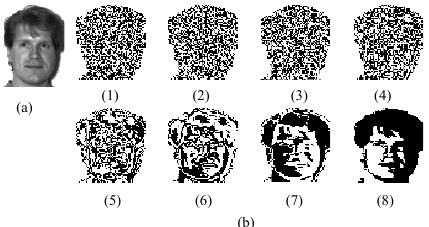
Fig.1 Original face image (a) and its eight bit-planes